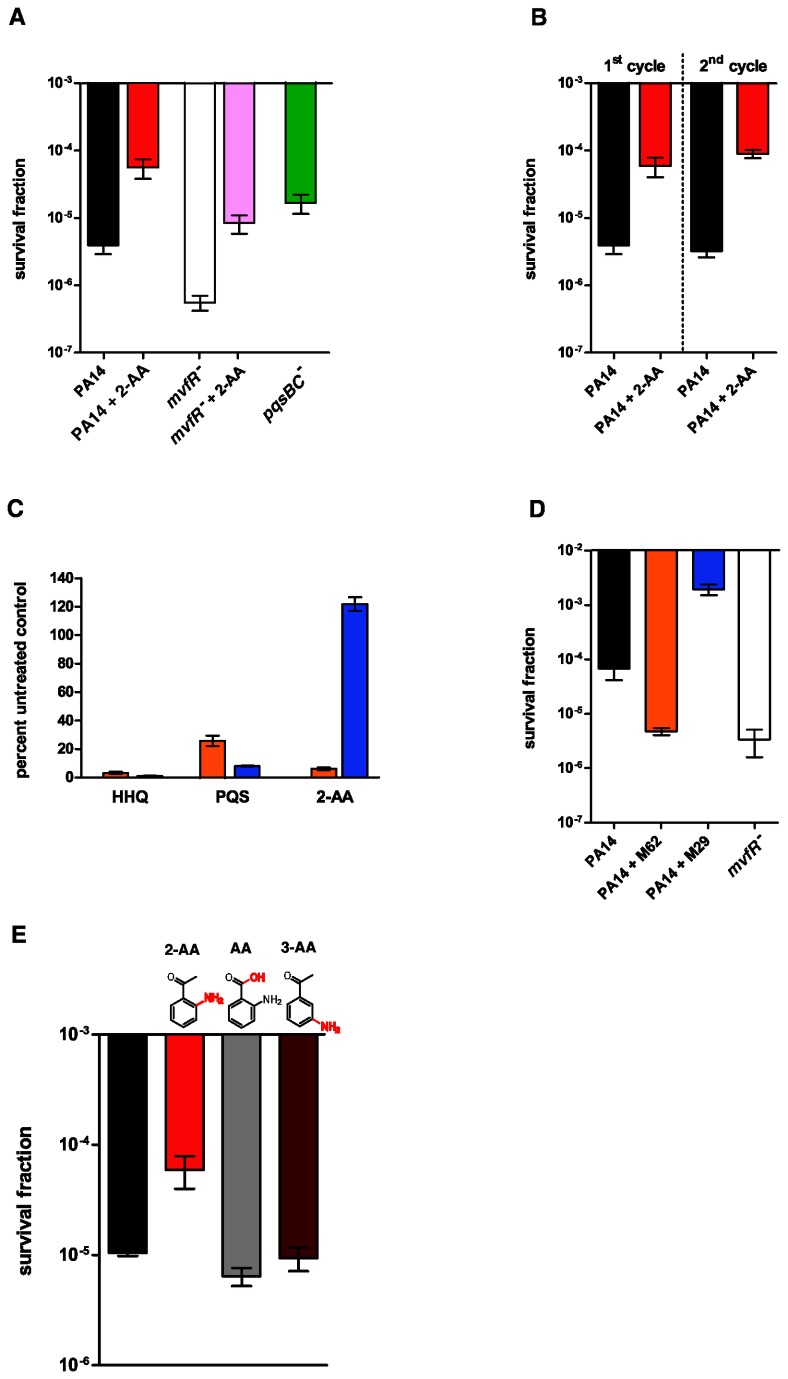
2-AA promotes antibiotic tolerance in P. aeruginosa.
A. Survival fraction of controls PA14 (black), PA14 + 2-AA (red), and mvfR
- (white), mvfR
- + 2-AA (pink) and pqsBC
- (green) cells grown to OD600nm= 2.0 followed by the addition of 10 μg/ml meropenem. All experiments were performed in triplicates, and results expressed as mean ± SD. Differences in persister fractions between PA14, mvfR
- and pqsBC- (p-value = 0.0016), between PA14 and PA14 + 2-AA (p-value = 0.0078) and between mvfR
- and mvfR
- + 2-AA (p-value = 0.0062), are statistically significant (one-way ANOVA, Tukey’s HSD test).
B. Persister cells are antibiotic tolerant, not antibiotic resistant. After meropenem killing (1st cycle), a single PA14 surviving colony was re-inoculated in fresh medium in the presence (red) or absence (black) of 2-AA (p-value = 0.0078, Student’s t-test), and antibiotic was applied again for 24 h (2nd cycle) (p-value = 0.0003, Student’s t-test). Additional single colonies tested gave similar results.
C, D. Chemical inhibition/stimulation of 2-AA production modulates persisters formation. Inhibition of 2-AA production (C) by compound M62 (orange) added to PA14 (black) culture decreased persisters formation (D) to a level similar to mvfR
- mutant (white), and stimulation of 2-AA production (C) by M29 (blue) increased PA14 persisters formation (D). The experiment was performed in triplicates, and results are expressed as mean ± SD. Differences in the persisters fractions between PA14, PA14 + M62 and PA14 + M29 are statistically significant (p-value=0.0001, one-way ANOVA, Tukey HSD). 
E. The accumulation of persister cells is 2-AA specific, as neither the precursor/analog AA (grey) nor the analog 3-AA (brown) increased the persister cell fraction. The experiment was performed in triplicates, and results are expressed as mean ± SD. Differences in the persisters fractions are only statistically significant between PA14 (black) and PA14 + 2-AA (red) (p-value=0.0004, one-way ANOVA, Tukey HSD).